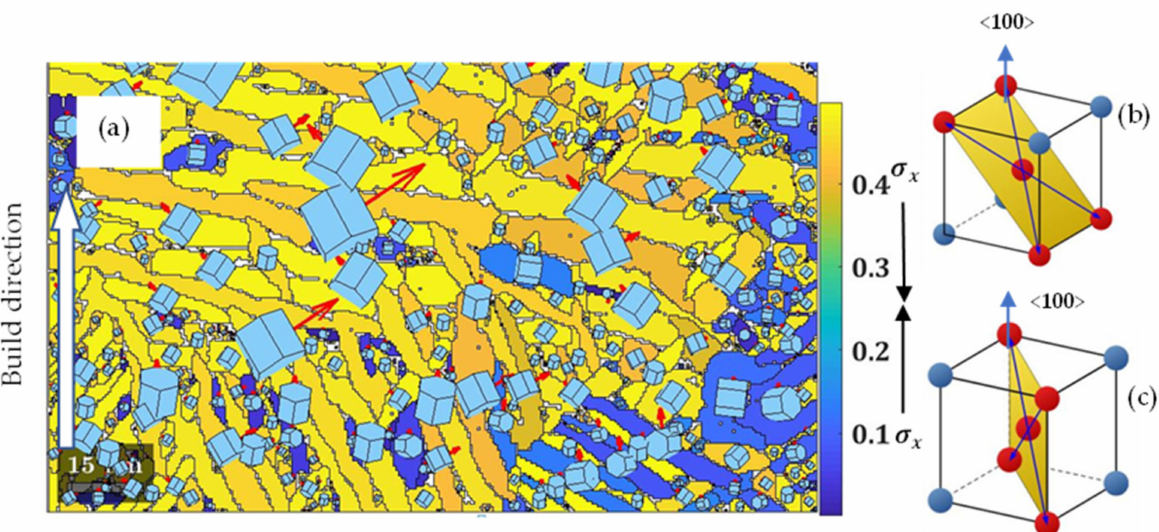
Figure 9. ( a ) Global Schmid factor distribution of basal slip system for α -laths in samples D with hcp crystal structures overlaid on each grain. The red arrows indicate the direction of Burgers vector (slip direction) and ( b , c ) are bcc structures with { 110 } slip planes at ( b ) 45 ◦ and ( c ) 0 ◦ to the <100>